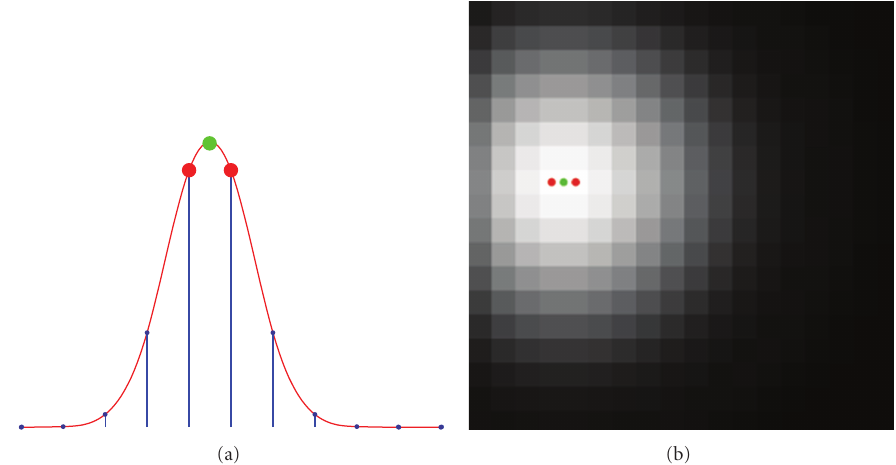
Figure 1: Critical point refinement. (a) A continuum Gaussian signal in 1 dimension and the corresponding sampled signal. The sampled signal shows maxima at two nearby positions (points in red), which are at di ff erent locations from the real maximum (point in green). (b) Rasterized version of a 2-dimensionalGaussian signal.Red points are the retrieved maxima,whereas the green point is the true maximum obtained after the refinement.